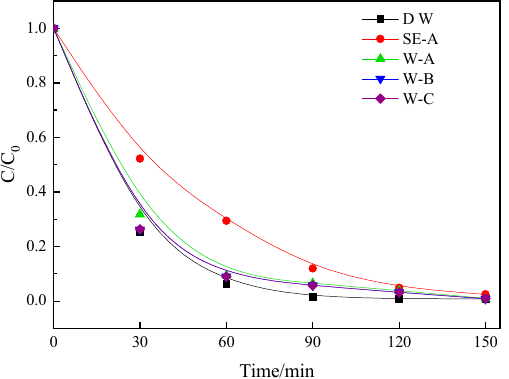
Figure 4. The effect of different components in wastewater on the photocatalytic degradation of